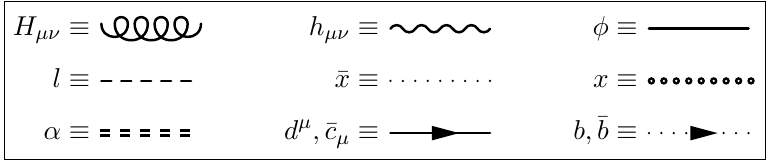
Table 1 . Dictionary of lines for the Feynman